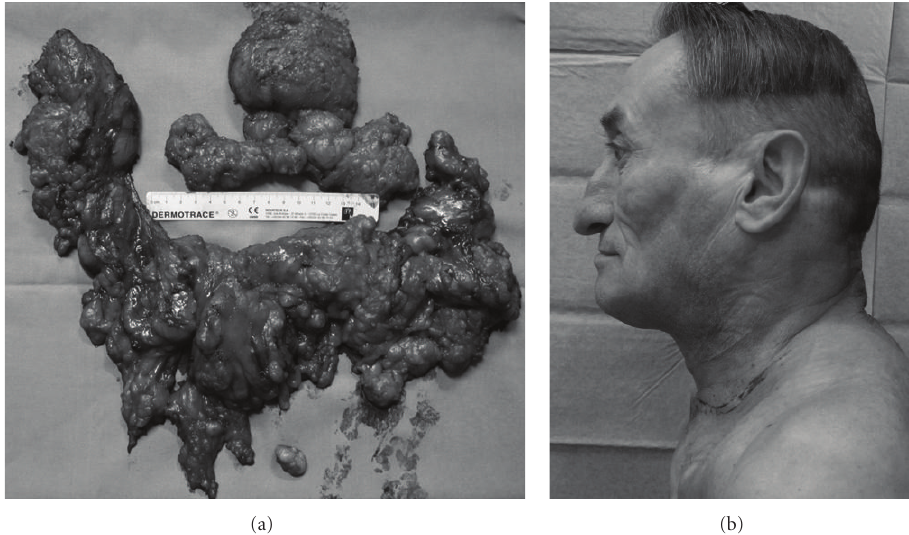
Figure 4: (a) operative specimen of subject 3; about 1180 g of fatty tissue was removed. (b) postoperative profile of the patient showing significant improvement in outward